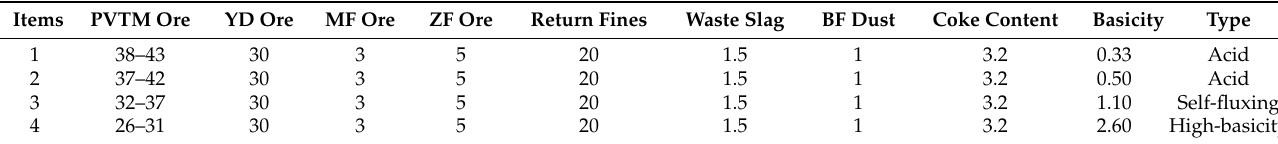
Table 3. Ore-matching scheme of sintering (%).